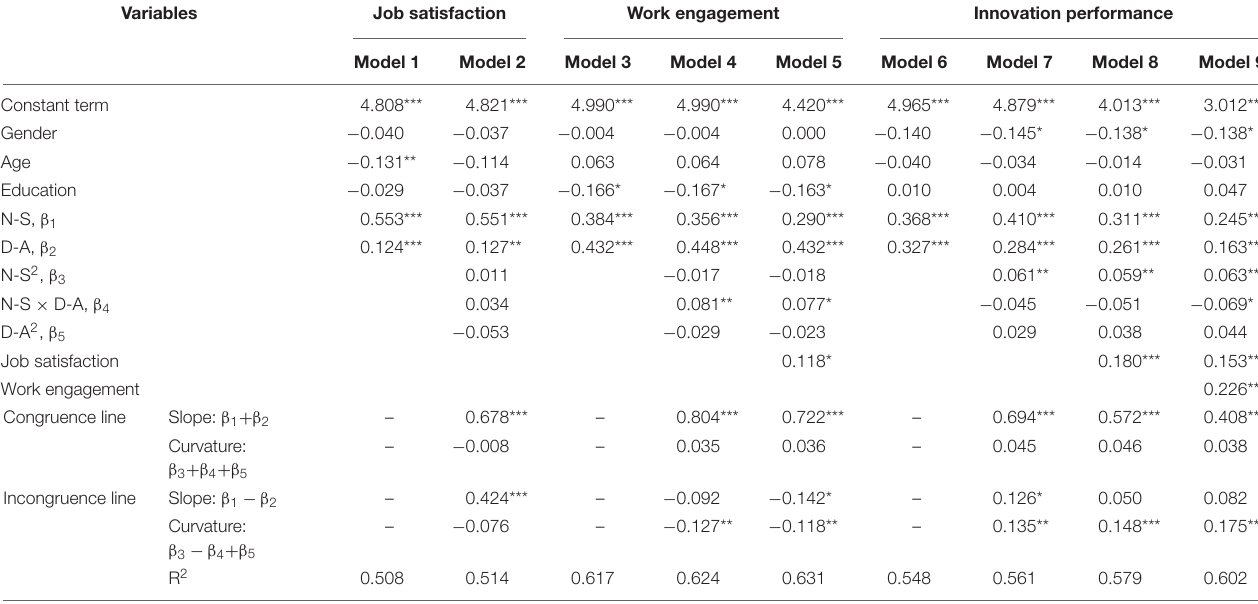
TABLE 3 | Polynomial regression